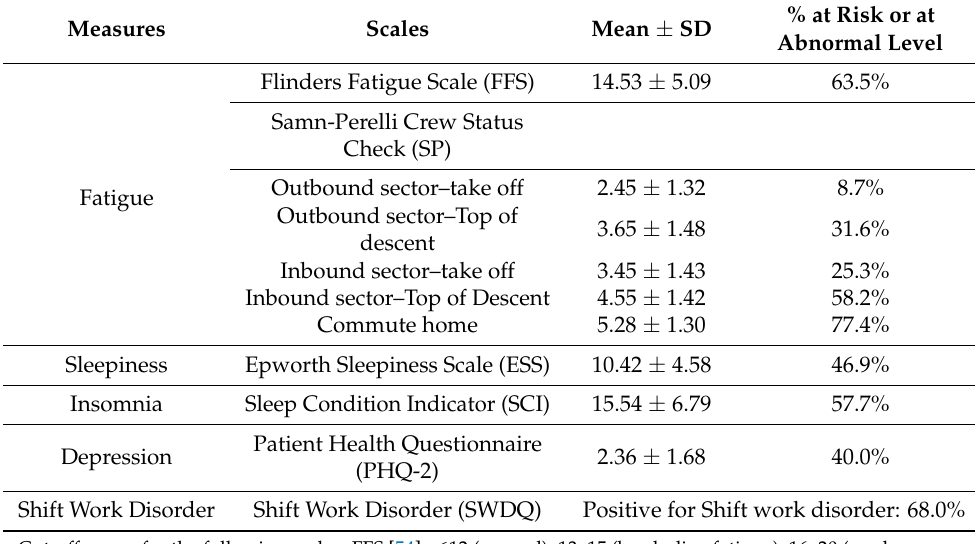
Table 2. Occurrence of fatigue, sleepiness, insomnia, depression and shift work disorder ( n = 930).